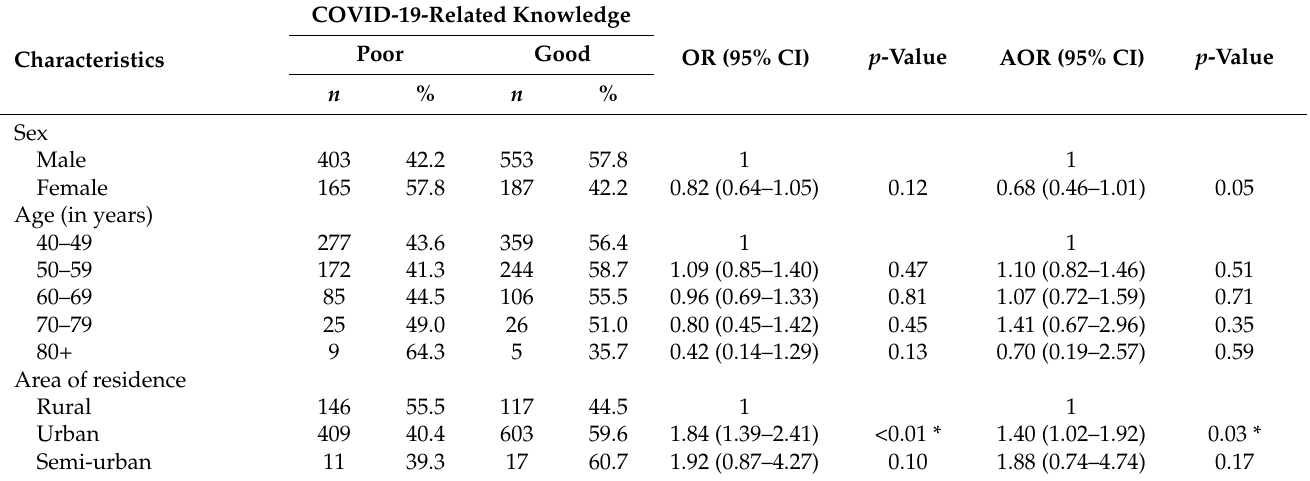
Table 2. Socio-demographic characteristics and